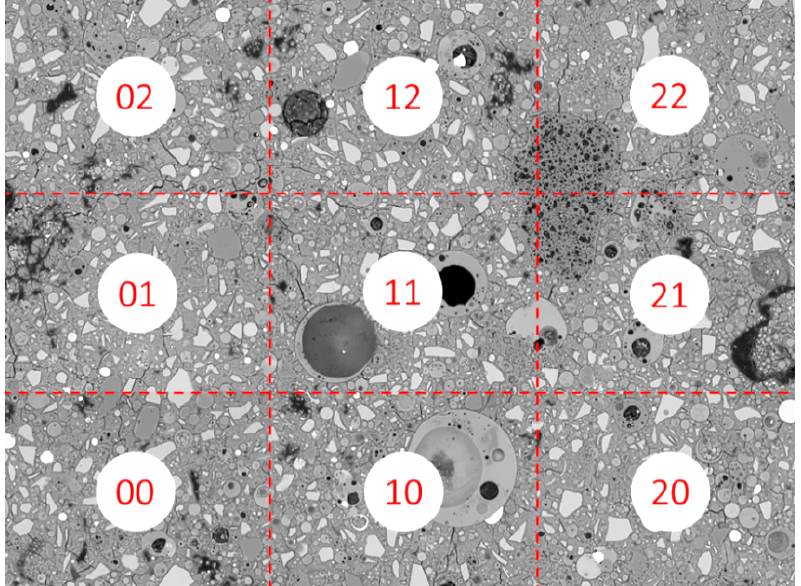
Figure 5. SEM-BSE image of the area of interest (3 × 3 matrix (fields are labelled 00–22), with an individual SI field comprising of 512 × 384 pixels) for paste microstructure characterization (sample is paste S50, unsealed cured for 28 days). All 9 fields of the area were analysed under the same analytical conditions. The total field width equals 750 microns.